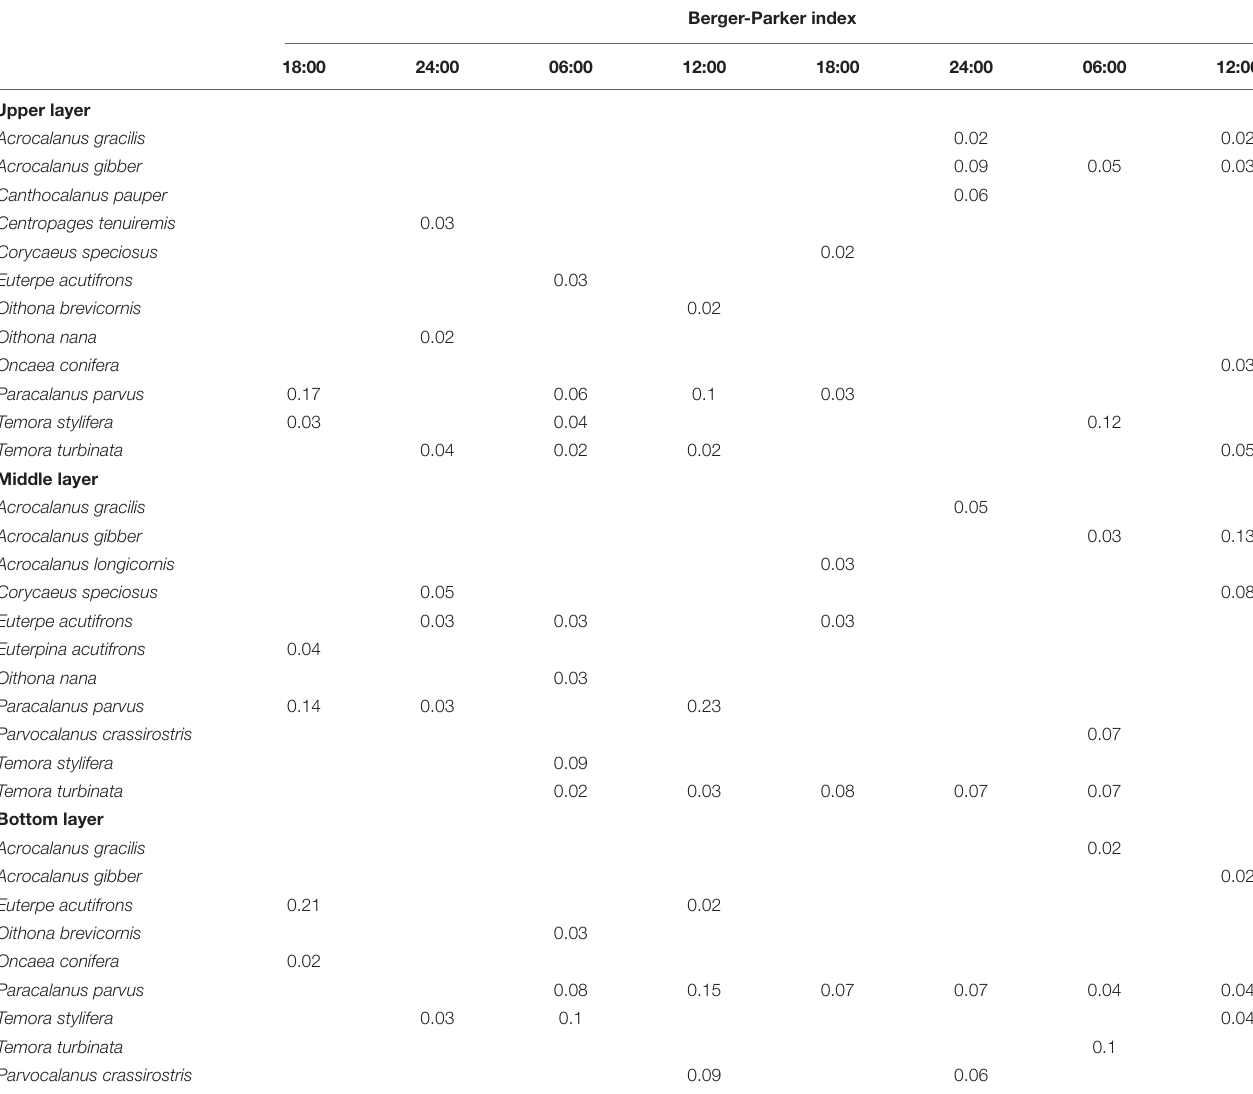
TABLE 3 | Predominant copepod species in the upper, middle, and bottom layers at the sampling station in Daya Bay during September 30 to October 2, 2014.